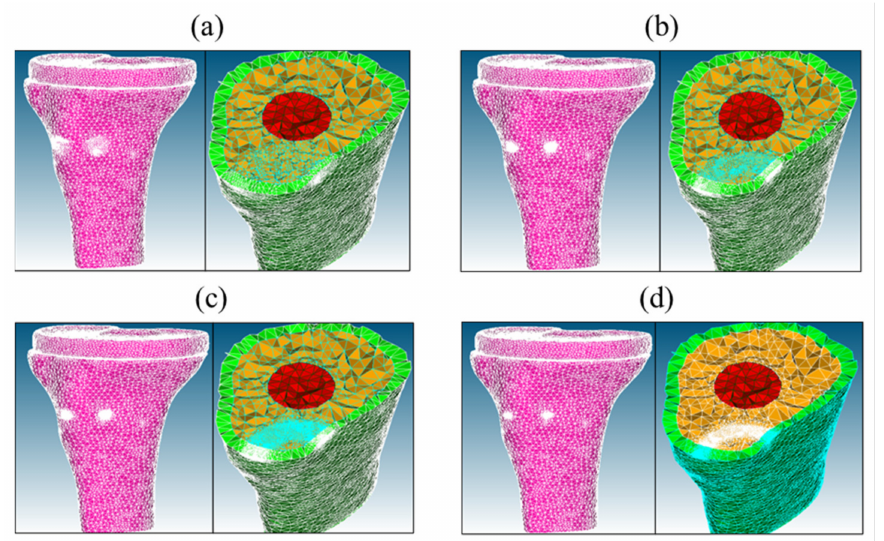
Figure 6. Four meshes of the tibia model with implant (TKR model)—coarse ( a ), medium ( b ), fine ( c ), and very fine ( d ) meshes.